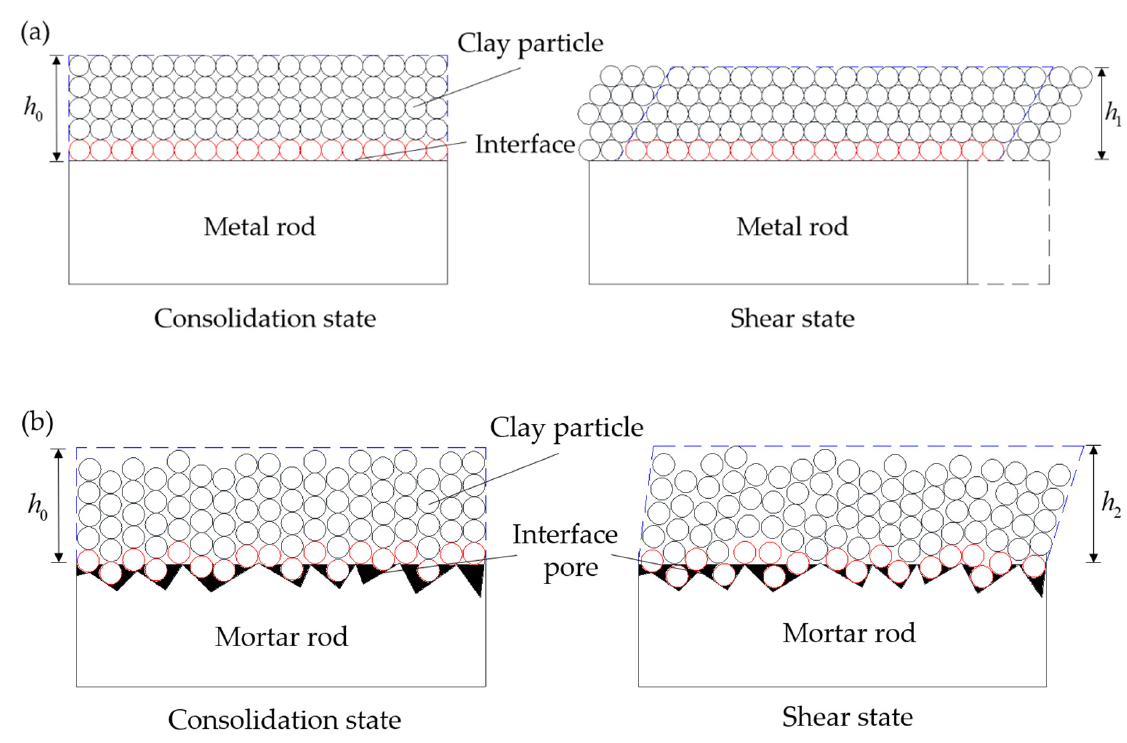
Figure 12. Schematic diagram of clay–structure interface: ( a ) metal rod; ( b ) mortar rod.